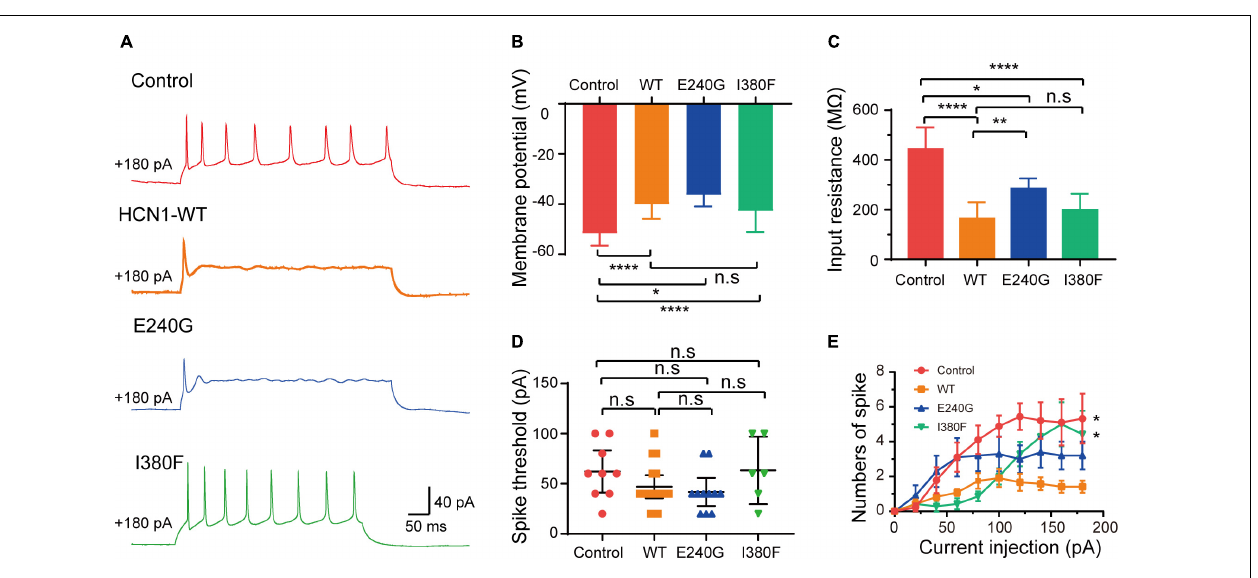
FIGURE 8 | Neuronal excitability was affected by HCN1 variants. (A) Representative recordings of action potential firing patterns in response to current injection (180 pA). (B) Bar graph summarizes the mean membrane potential in neurons expressing different HCN1 channel types. Analysis was done by Bonferroni post hoc test. (C) Bar graph shows mean input resistance in neurons expressing different HCN1 channel types. Dunnett’s T3 post hoc test. (D) Bar graph shows spike thresholds elicited by current injection were not affected. Analysis was done by Mann–Whitney test. (E) Plot of the mean firing rates of neurons in response to current injections. * P < 0.05, ** P < 0.01, **** P <